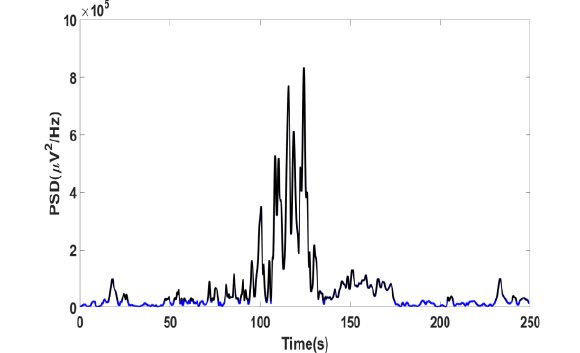
Figure 4. projection of the ridge of the wavelet spectrogram on the power spectral density (PSD) and time axes